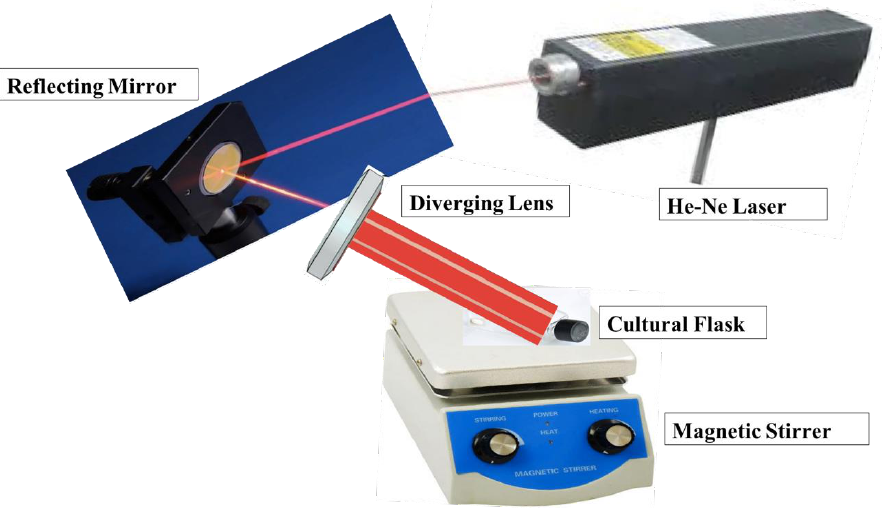
Figure 1. Laser irradiation experimental setup.